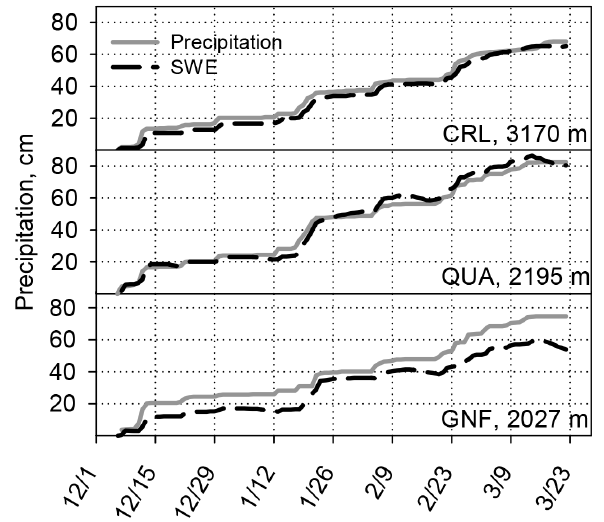
Figure 6. Accumulated gauge precipitation and snow-pillow SWE for the three sites with both measurements. Locations are shown in Fig.